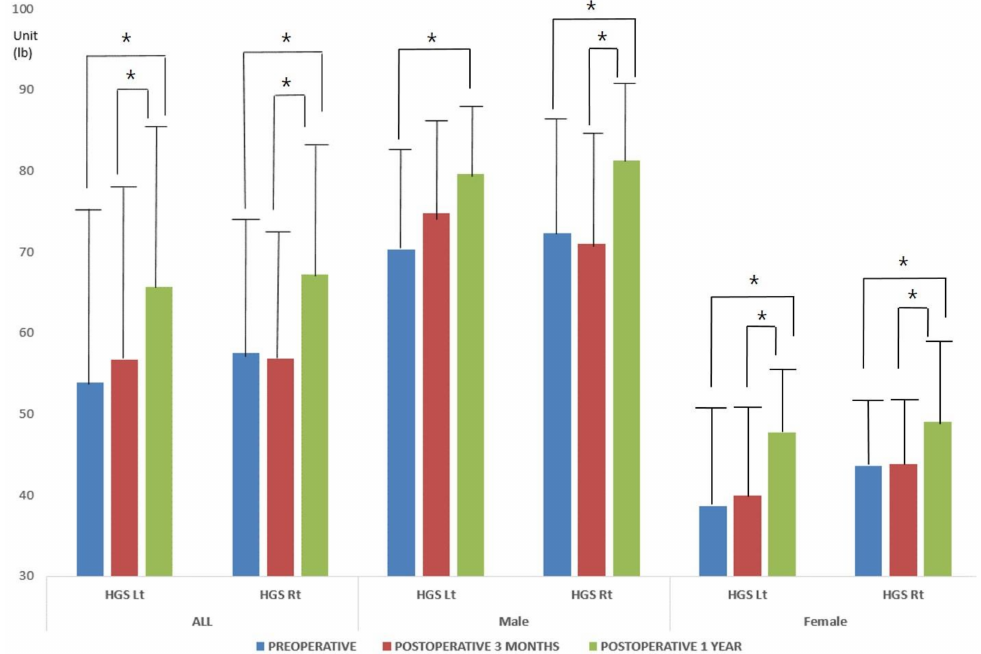
Figure 2. The mean HGS of both hands improved significantly at postoperative 3 months and 1 year compared with the preoperative measures in all patient groups ( p = 0.000 for all; ANOVA). * indicates the statistical difference between measures. Table 4. Hand grip strength measurements. (Unit: lbs.) All Males Females p